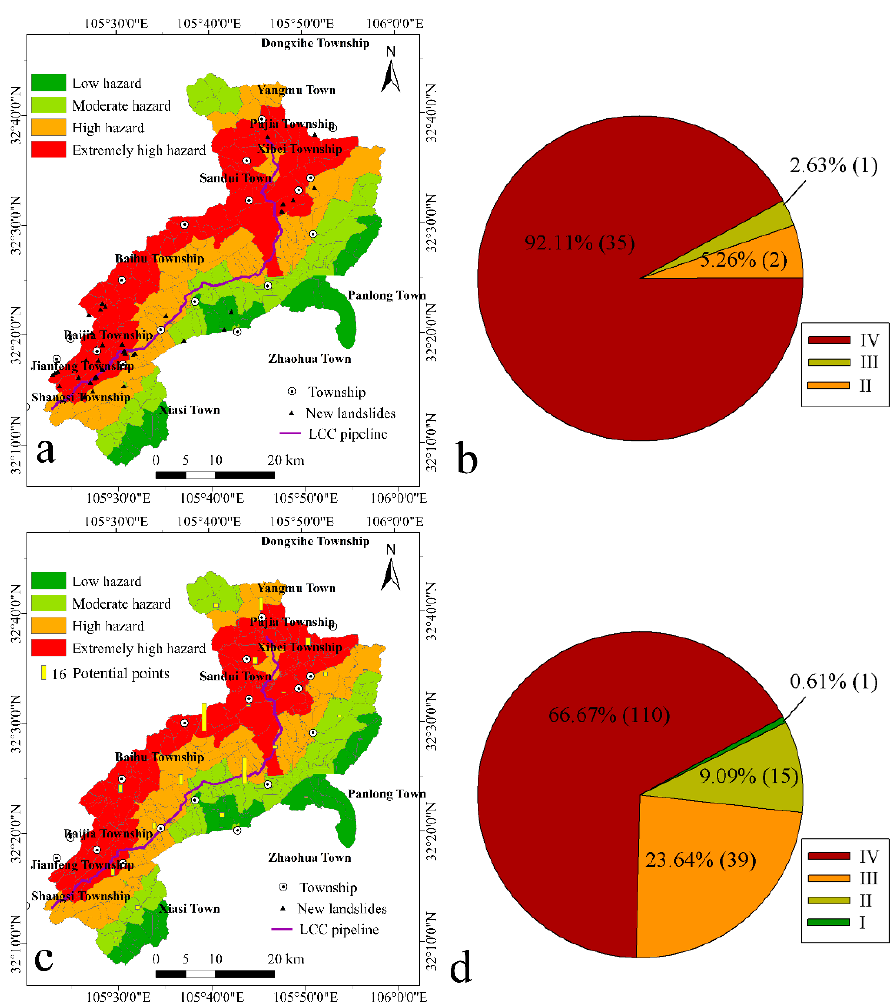
Figure 10. Assessment result for prediction capability analysis. The spatial distribution characteristic ( a ) and the statistical results ( b ) of new landslides from 2015 to 2018. The spatial distribution characteristic ( c ) and the statistical results ( d ) of landslide potential points in 2019.